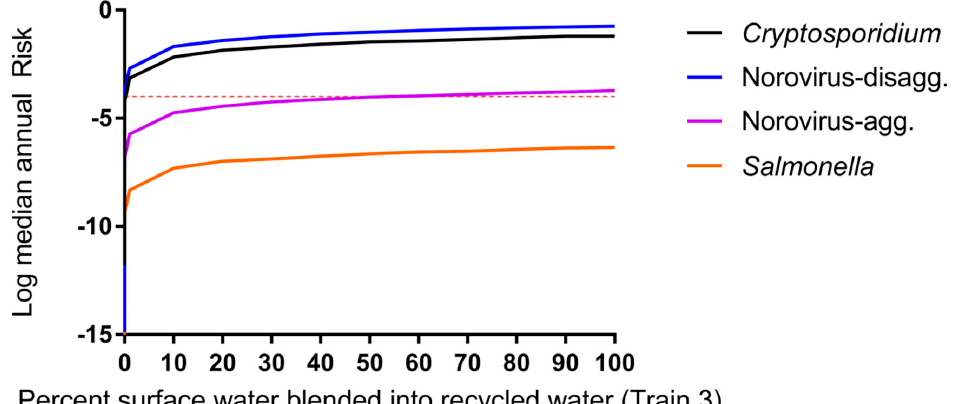
Figure 5. Impact of blending DPR water with 50% effluent-impacted surface water for treatment Train 3, case c, F dilution = 0.5, 0 < F blend < 1. Microbial risk is driven by surface water quality (not DPR water) for